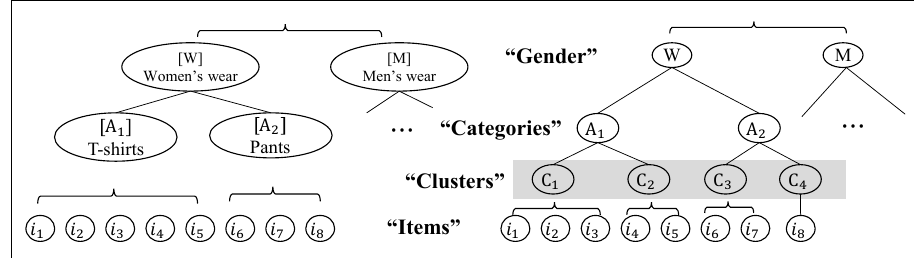
Figure 1. Hierarchy of apparel products.